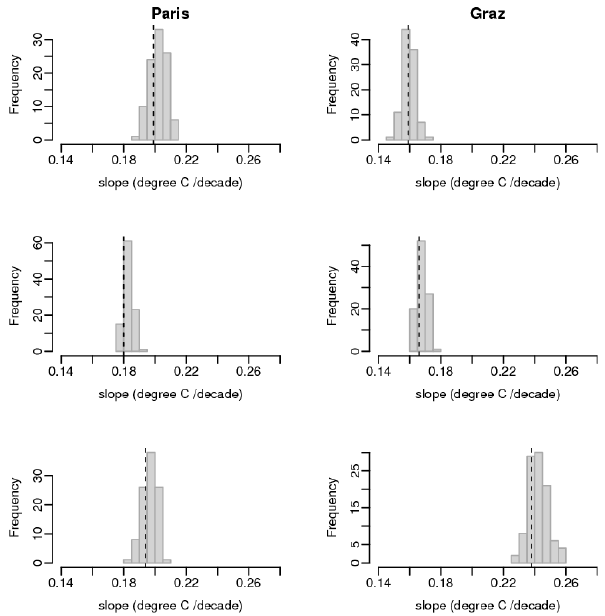
Fig. 4. Bootstrap distribution of quantile slopes for Paris (left) and Graz (right) records. From top to bottom: quantile τ = 0 . 05, τ = 0 . 5 and τ = 0 . 95. The dashed vertical line indicates the punctual estimate (Table 2).